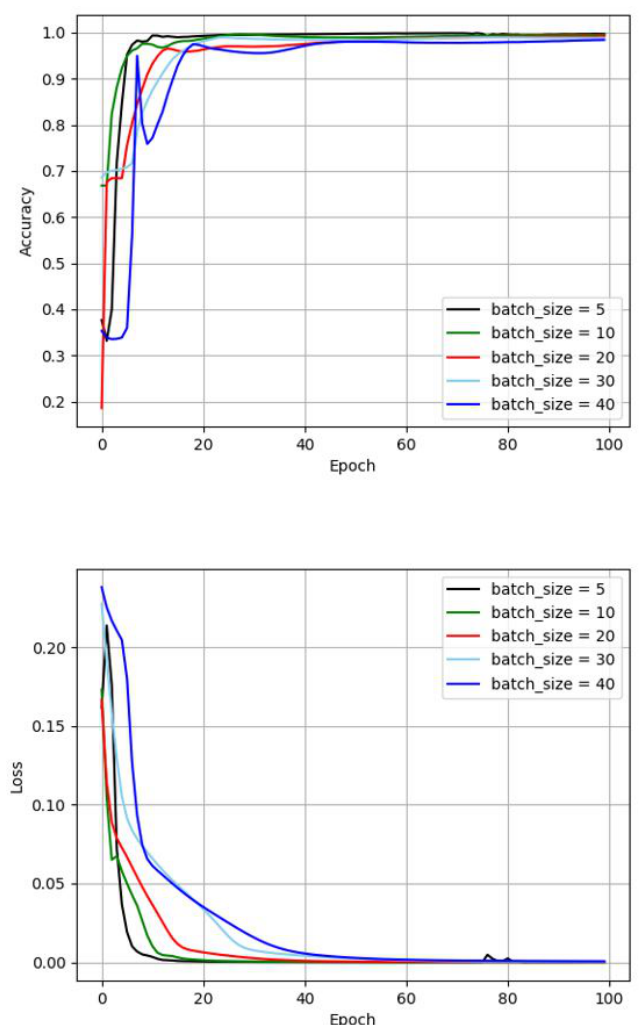
Figure 13. Localization accuracy and network loss of training data in terms of number of batch